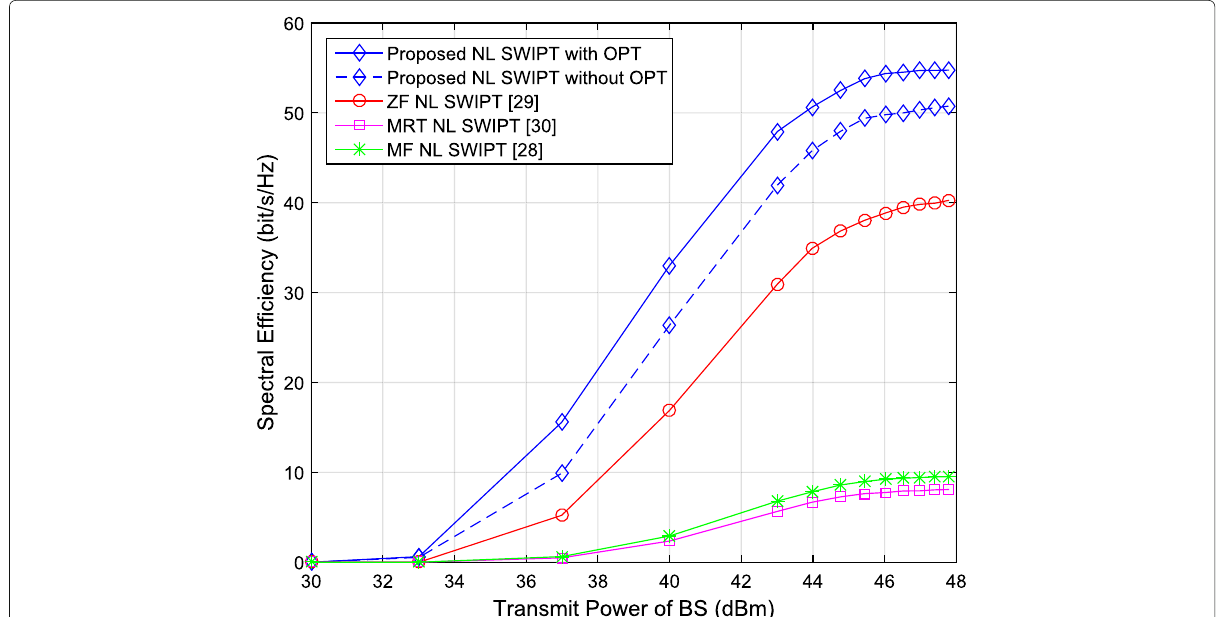
Fig. 5 Spectral efficiency of the proposed SWIPT protocol, the channel coherent time is 300 symbols, N = 256. The processing energy of TE is set to 10 − 8